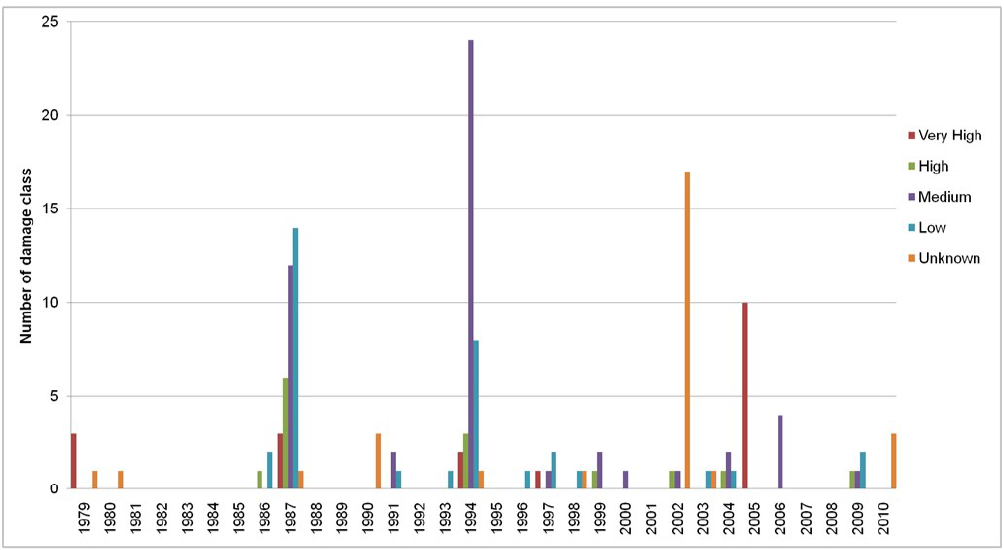
Figure 10. The annual distribution of categories of damages in the study area during